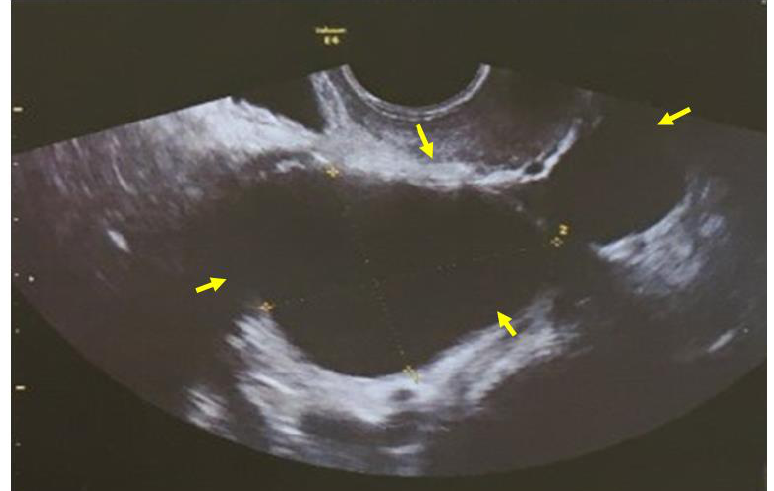
Figure 1. Transvaginal ultrasound imaging: the allantoid form cystic mass at the anatomical position of the right adnexa (yellow arrows) corresponding to primary fallopian tube carcinoma was misdiagnosed as a two-chambered cystic lesion of the ovary (our case).